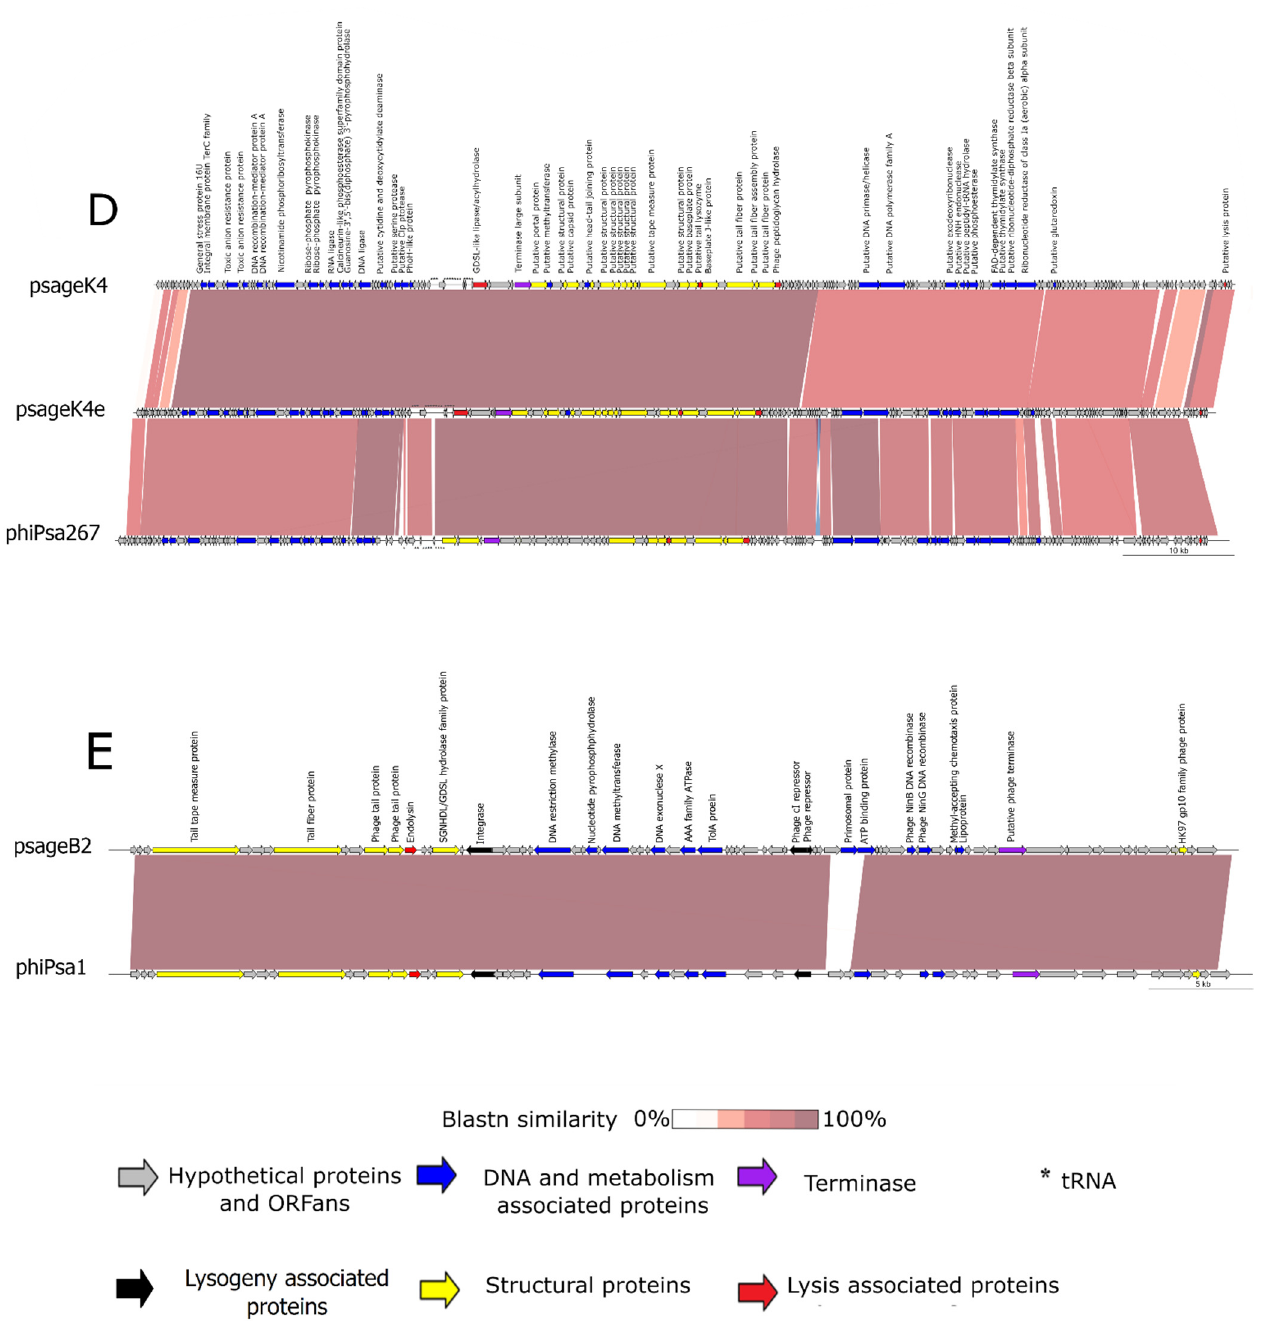
Figure 2. Genome organization of pphageB1 phage compared with MR18 ( A ), psageB1 compared with nickie ( B ), psageA1 ( C ), psageK4 compared with psageK4e and phiPsa267 ( D ), and psageB2 compared with phiPsa1 ( E ). The arrows indicate annotated ORFs; and the asterisks, annotated tRNA sequences. Yellow arrows indicate ORFs associated with structural proteins, blue DNA- and metabolism-associated ORF, red ORFs that encode for lysis associated proteins, and purple ORFs homologues to terminases. The intensity of the color between two compared sequences indicates percentages of BLASTn similarity.